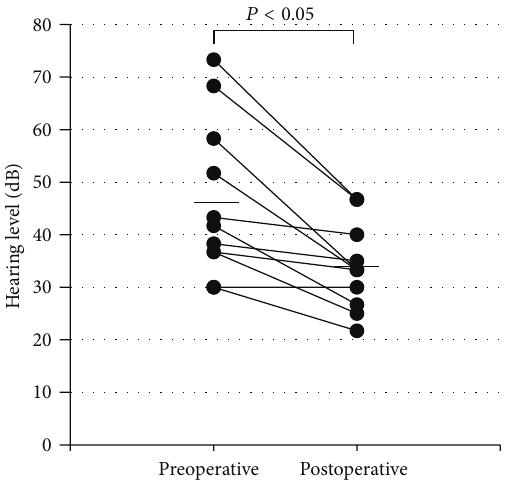
Figure 2: Scatterplots of hearing levels at preoperative and postop- erativestages.Significantimprovementofhearinglevelisrecognized after surgery. Horizontal bars denote averages for each stage.